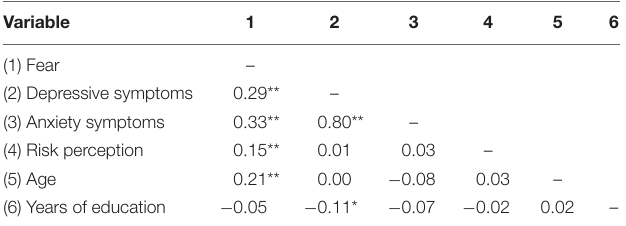
TABLE 3 | Pearson’s correlation coefficients between fear and the continuous predictors. Variable